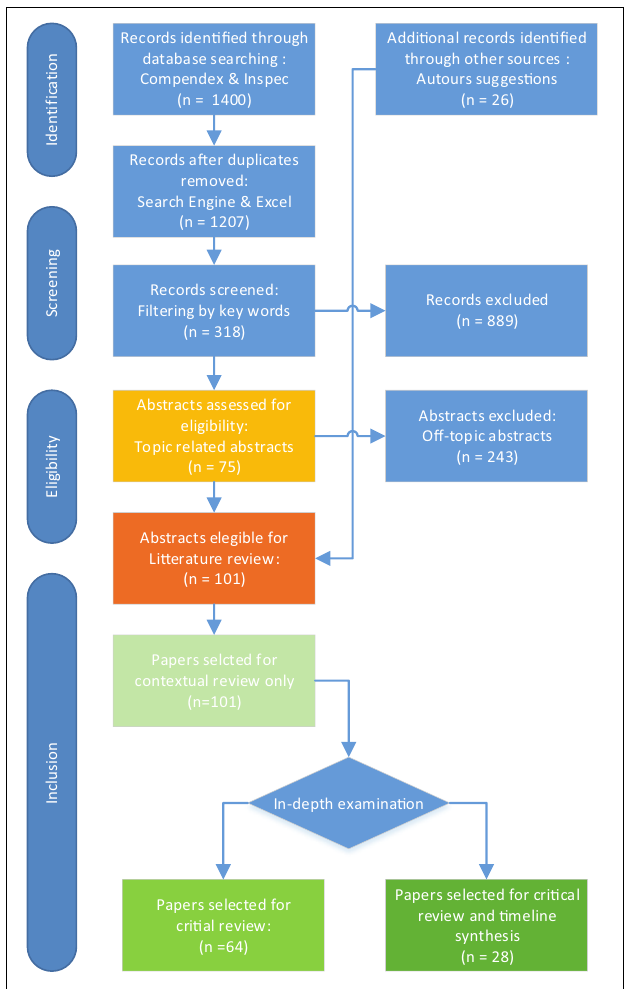
FIGURE 1 | Systematic review flowchart (adapted from Moher et al.,